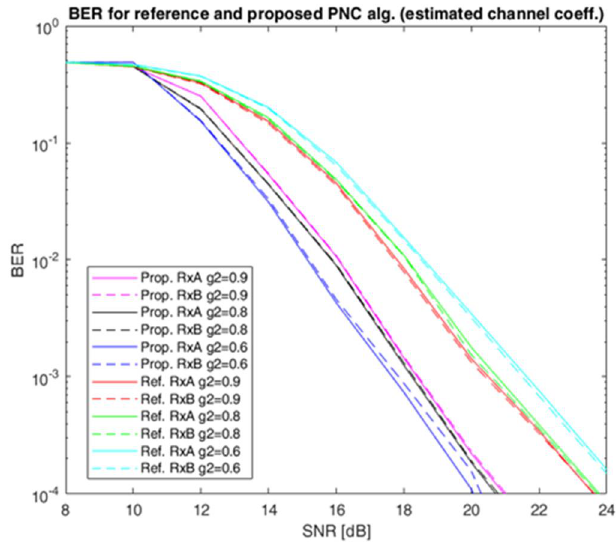
Figure 9. BER on the output of receivers of terminals A and B for the proposed and reference PNC algorithms for the number of N p = 6 OFDM pilot symbols used in channel estimation (large values of g 2 ).